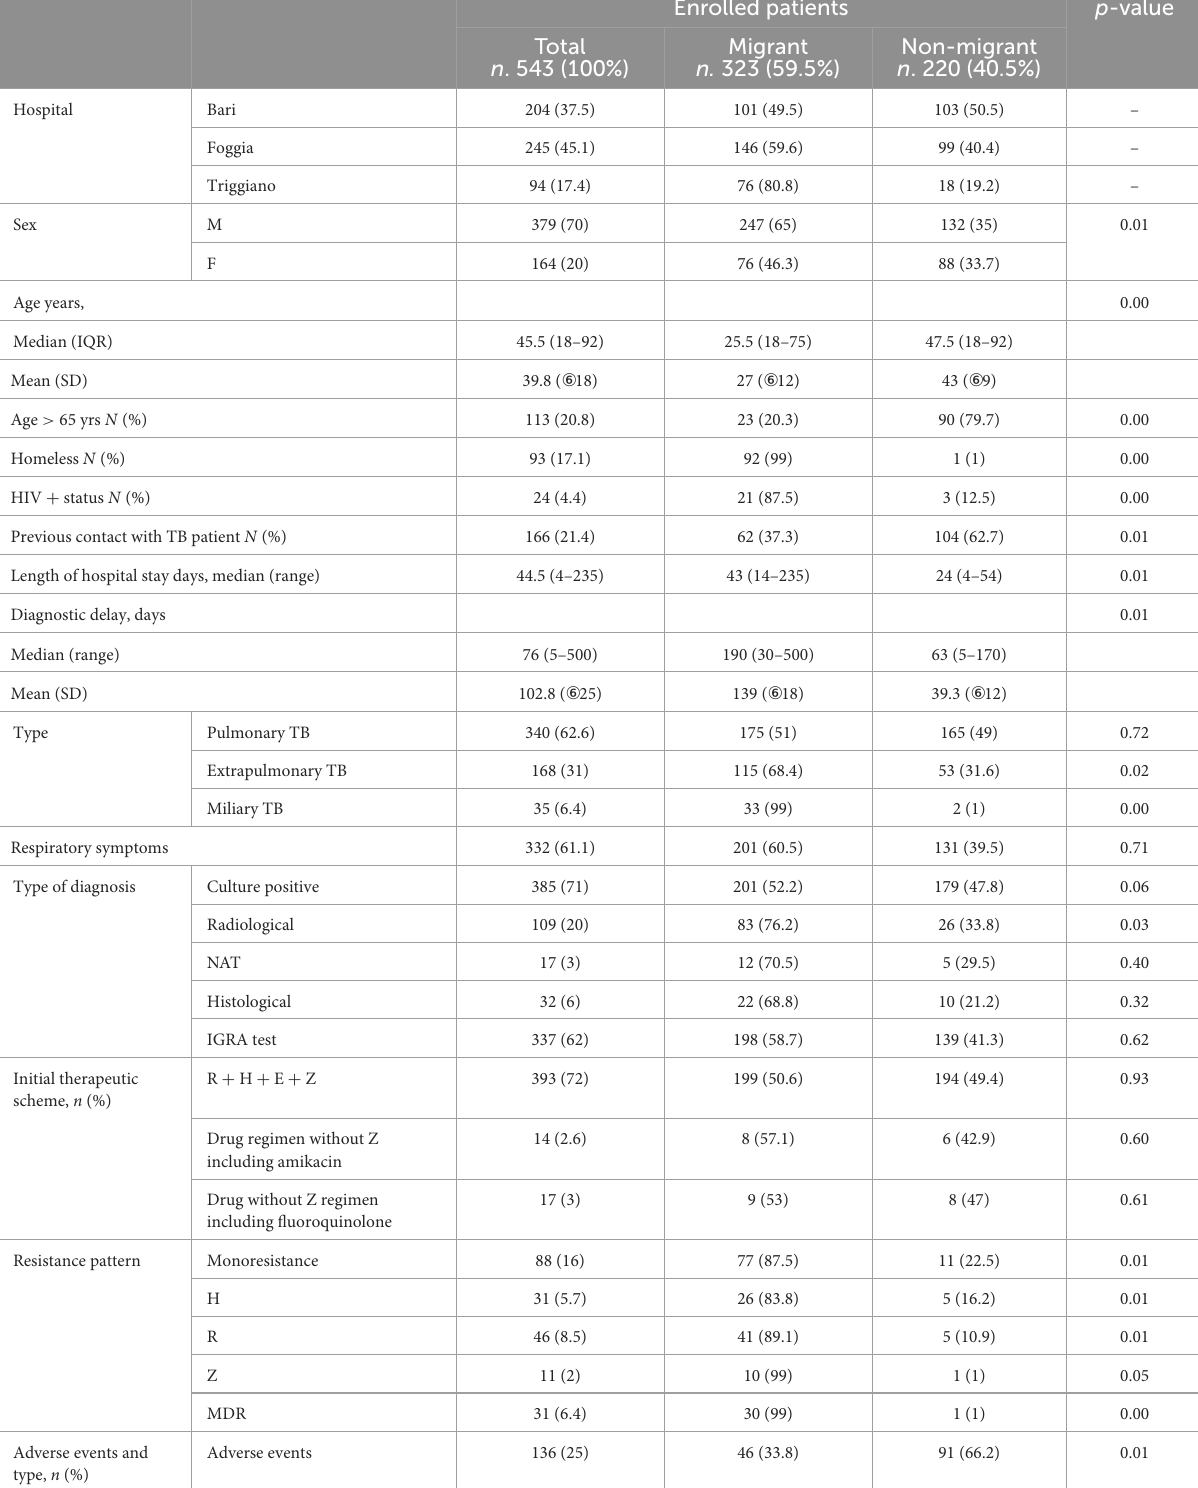
TABLE 1 Demographic, clinical, and therapeutic data of 543 patients stratified by migrant